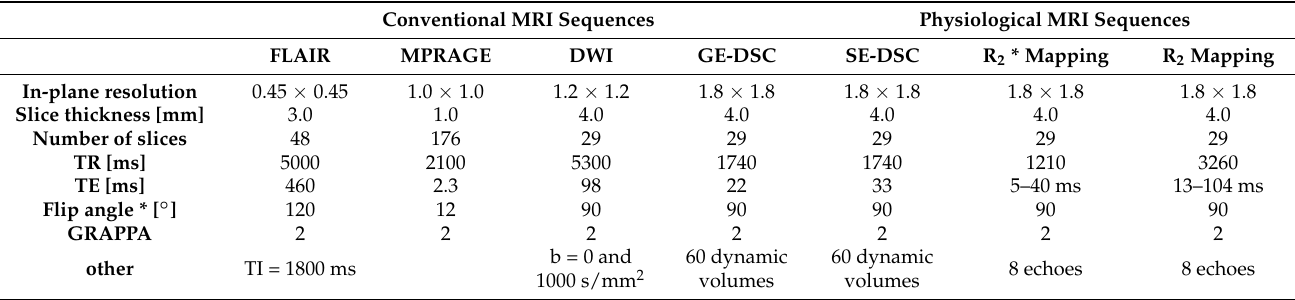
Table 2. Sequence parameters of the MRI study